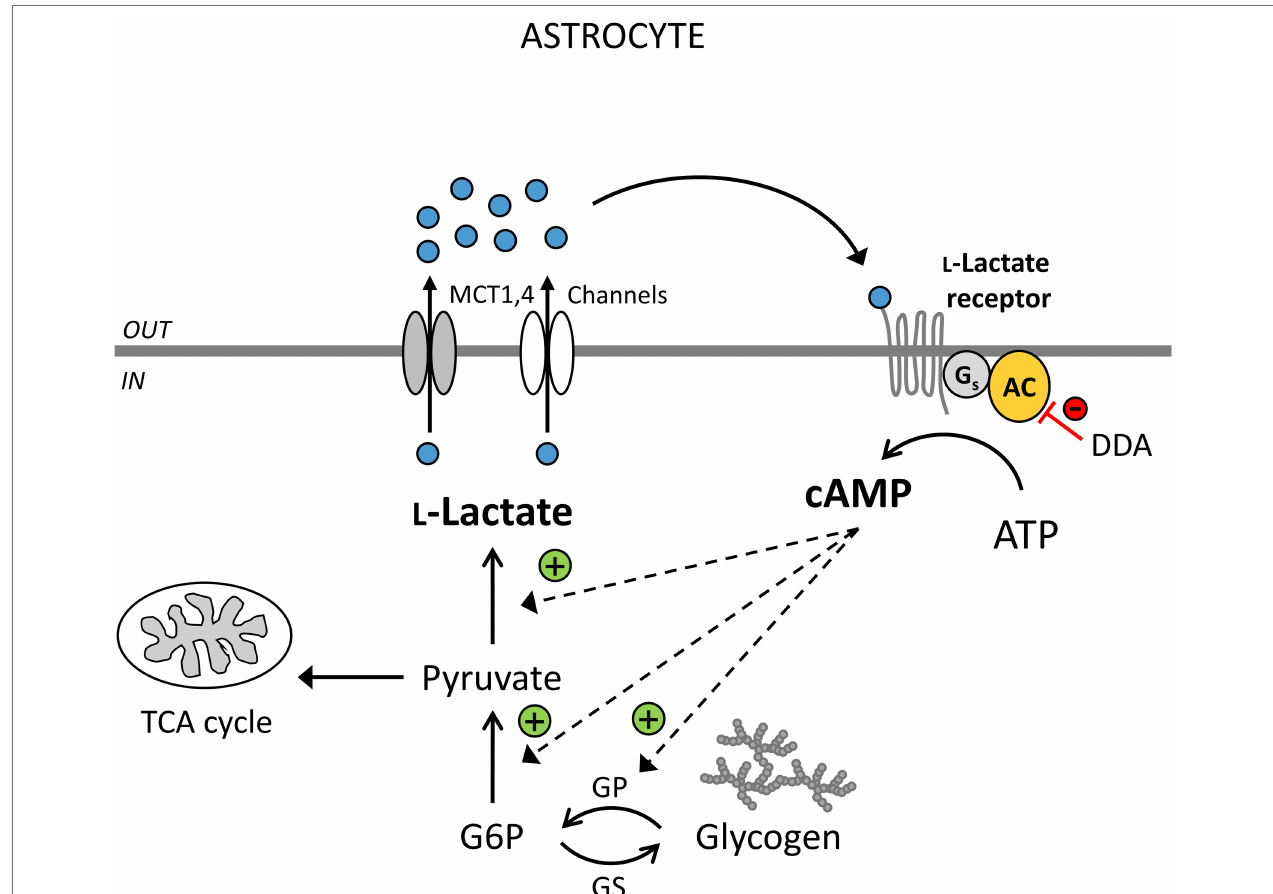
FIGURE 1 | Extracellular l -lactate enhances cytosolic l -lactate production via yet unidentified receptors coupled to adenylate cyclase (AC) activity and cAMP signaling in astrocytes. l -Lactate (blue circles) is formed in astrocytes (IN) in the process of aerobic glycolysis and released through monocarboxylate transporters (MCTs) 1,4 and/or l -lactate-permeable channels. Extracellularly (OUT), l -lactate can be transported to neighboring cells as a fuel, it can exit the brain via the circulation, or act as a signaling molecule. By binding to the l -lactate-sensitive receptors (LLRs) on the surface of astrocytes, it can stimulate AC and cAMP production. This triggers glycogen degradation, glycolysis, and more l -lactate production. The inhibition of AC by 2 ' ,5 ' -dideoxyadenosine (DDA) causes a reduction in the astroglial LLR-mediated increase in cAMP and l -lactate levels (red line). l -Lactate-positive feedback mechanism (“metabolic excitability”) in astrocytes